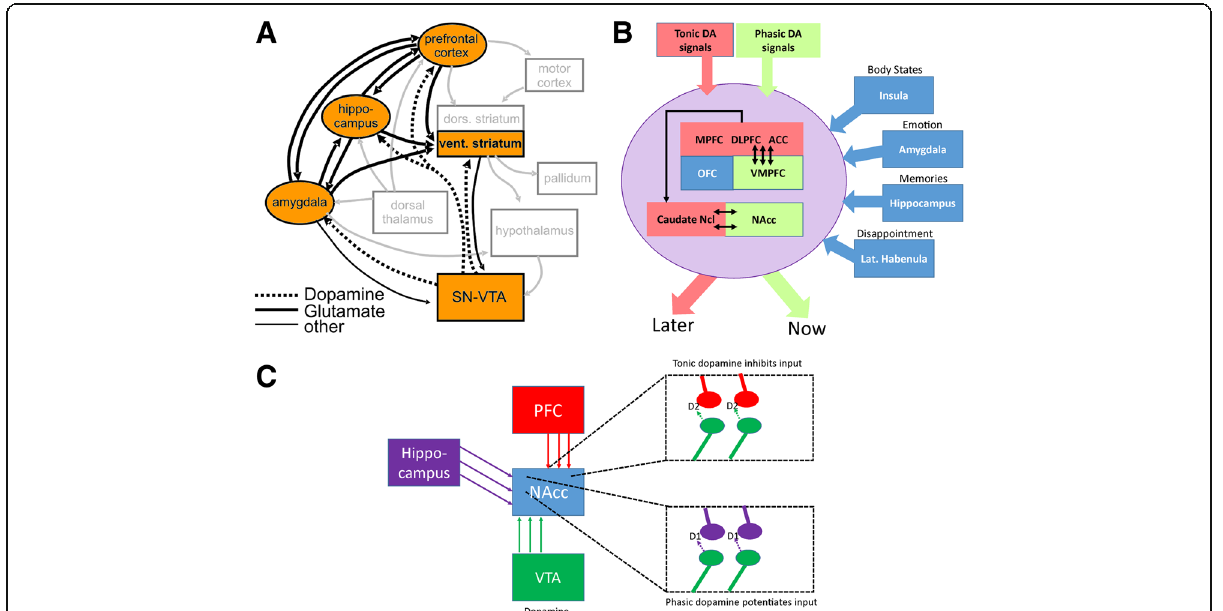
Fig. 1 a Scheme of the reward valuation network as derived from a neuroimaging study by Camara et al. [11] (orange boxes, black arrows) embedded in a wider motivation/learning circuit (gray boxes and arrows). The wider network is based on Kelley et al. (2004), omitting unspecific hypothalamic/thalamic projections. b Model of intertemporal choice behavior as proposed by Volkow and Baler [93]. The regions colored in red are considered to support decisions for later, larger rewards ( “ LATER ” ), whereas the green areas support decisions for immediately available rewards ( “ NOW ” ). Regions depicted in blue modulate intertemporal choice behavior by integrating different information (described in black lettering). Please note, that tonic dopamine (DA) signals are thought to favor LATER rewards by influencing frontal regions. By contrast, phasic DA signals drive decisions towards choosing the immediately available reward (NOW). Regions: dorsolateral prefrontal cortex (dlPFC), medial PFC (mPFC), ventromedial PFC (vmPFC), orbitofrontal cortex (OFC), anterior cingulate cortex (ACC), nucleus accumbens (NAcc). c Illustration of the role of phasic and tonic dopaminergic projections (after [32]): The Nacc serves as an integrator of afferent inputs from frontal and limbic regions. Of note, the input from the PFC is regulated by dopaminergic input from VTA via presynaptic D2 receptors, with D2 receptor stimulation resulting in an inhibition of PFC input to the Nacc. The presynaptic neurons are stimulated by tonic dopamine neuron firing leading to low tonic levels of dopamine. High-amplitude, phasic dopamine signals on the other hand lead to D1 receptor activation that potentiates the hippocampal input to the